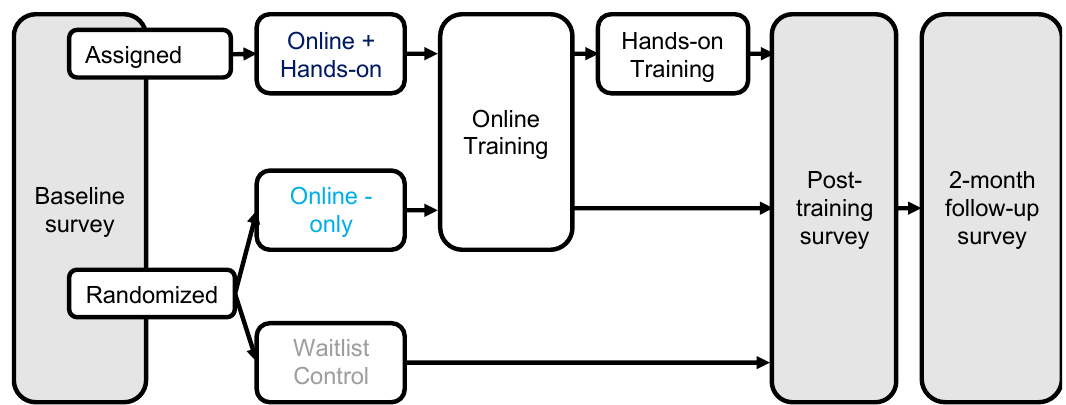
Figure 1. Timeline of procedures and assessment for laboratory animal personnel. All participants were given a baseline survey before group assignment. Then, they were either assigned or